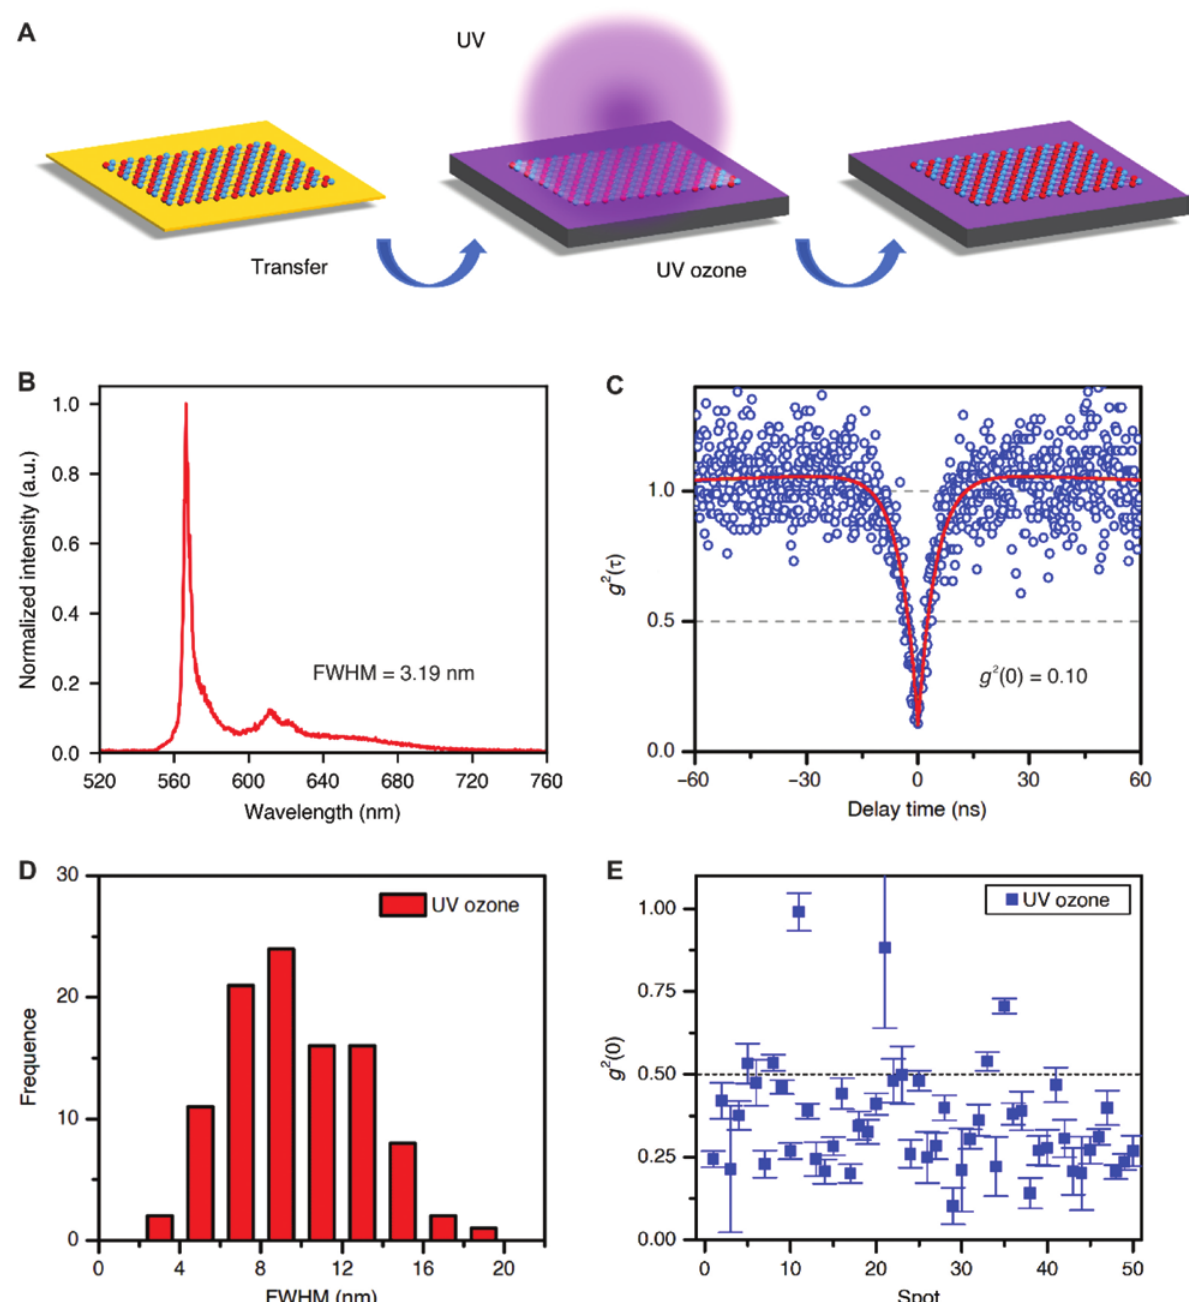
Figure 2: Room-temperature optical characterizations of hBN films that were processed by UV ozone. (A) Schematic illustration of the UV ozone treatment. (B) Normalized PL spectrum of a representative SPE. The ZPL is centered at 567.1 nm with an FWHM of 3.19 nm. (C) Autocorrelation measurement of the emitter excited by a 532-nm CW laser. The intensity at zero delay time [ g 2 (0)] is 0.10 ± 0.04 (without background correction). (D) Histogram of the FWHM of 100 emitters. The average FWHM is ~ 9.0 nm. (E) Scatter plot of g 2 (0) values from the same group of samples shown in (D), showing that 88% of the emissions are from SPEs. Average g 2 (0) value is 0.36 ± 0.17. Error bars plotted are derived from corresponding fitting